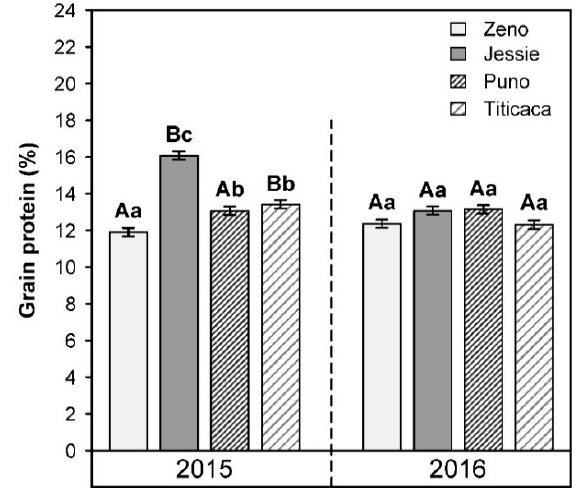
Figure 4. Grain protein (%) content for the two years and four quinoa cultivars (Zeno, Jessie, Puno, Titicaca). Within year, bars headed by the same lowercase letter are not significantly different ( p < 0.05). Capital letters compare the two years for the same cultivar, bars headed by the same letter are not significantly different ( p < 0.05). Error bars indicate the standard error of the mean.